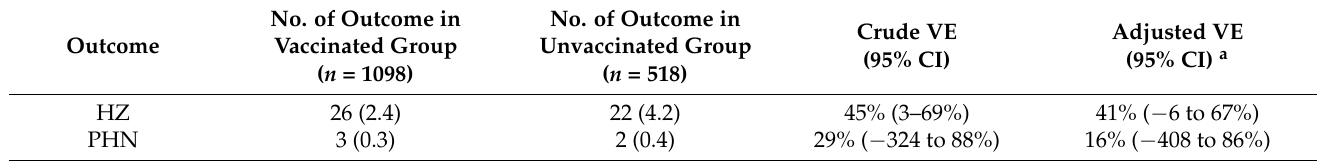
Table 3. Overall vaccine effectiveness against HZ and PHN.